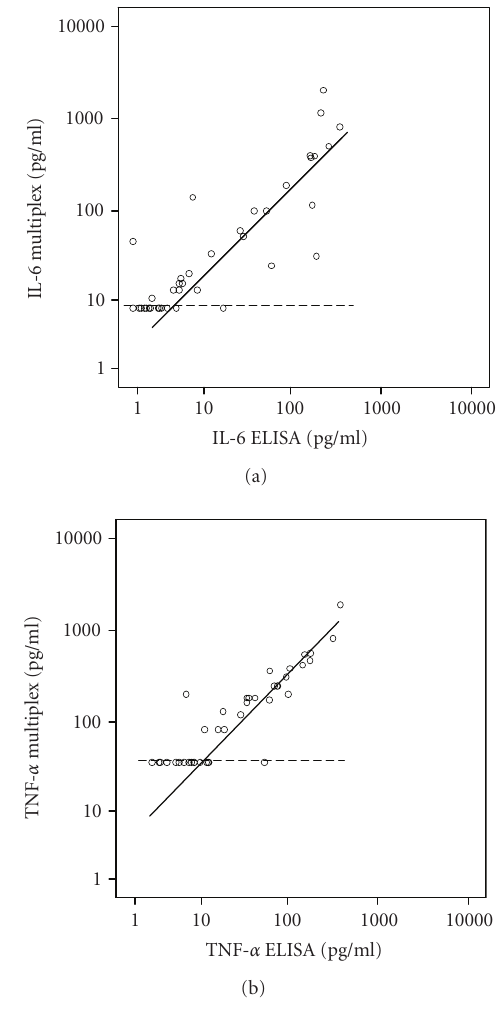
Figure 1: Regression curves of 44 samples of blister fluid obtained from 22 CRPS1 patients, both from the involved and the nonin- volved extremity. Values calculated in pg/mL were plotted on log- arithmic scales. Regression lines were calculated taking into ac- count the left-censored values due to detection limits as described in the statistical methods. Dotted lines indicate detection levels of the multiplex-25 cytokine assay. (a) Regression curve of IL-6 data from the multiplex-25 cytokine assay and the ELISA kit ( r = 0 . 85, P < . 001), (b) regression curve of TNF- α data from the multiplex- 25 cytokine assay and the ELISA kit ( r = 0 . 88, P < .